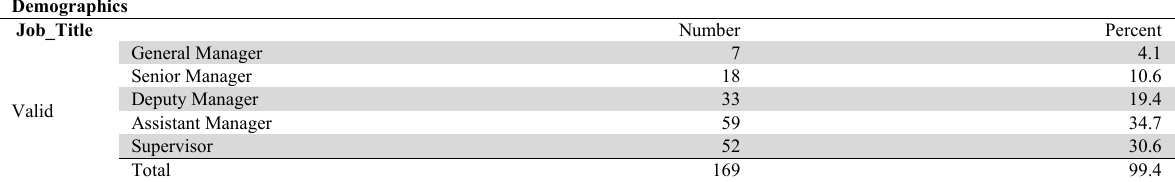
Personal characteristics of the